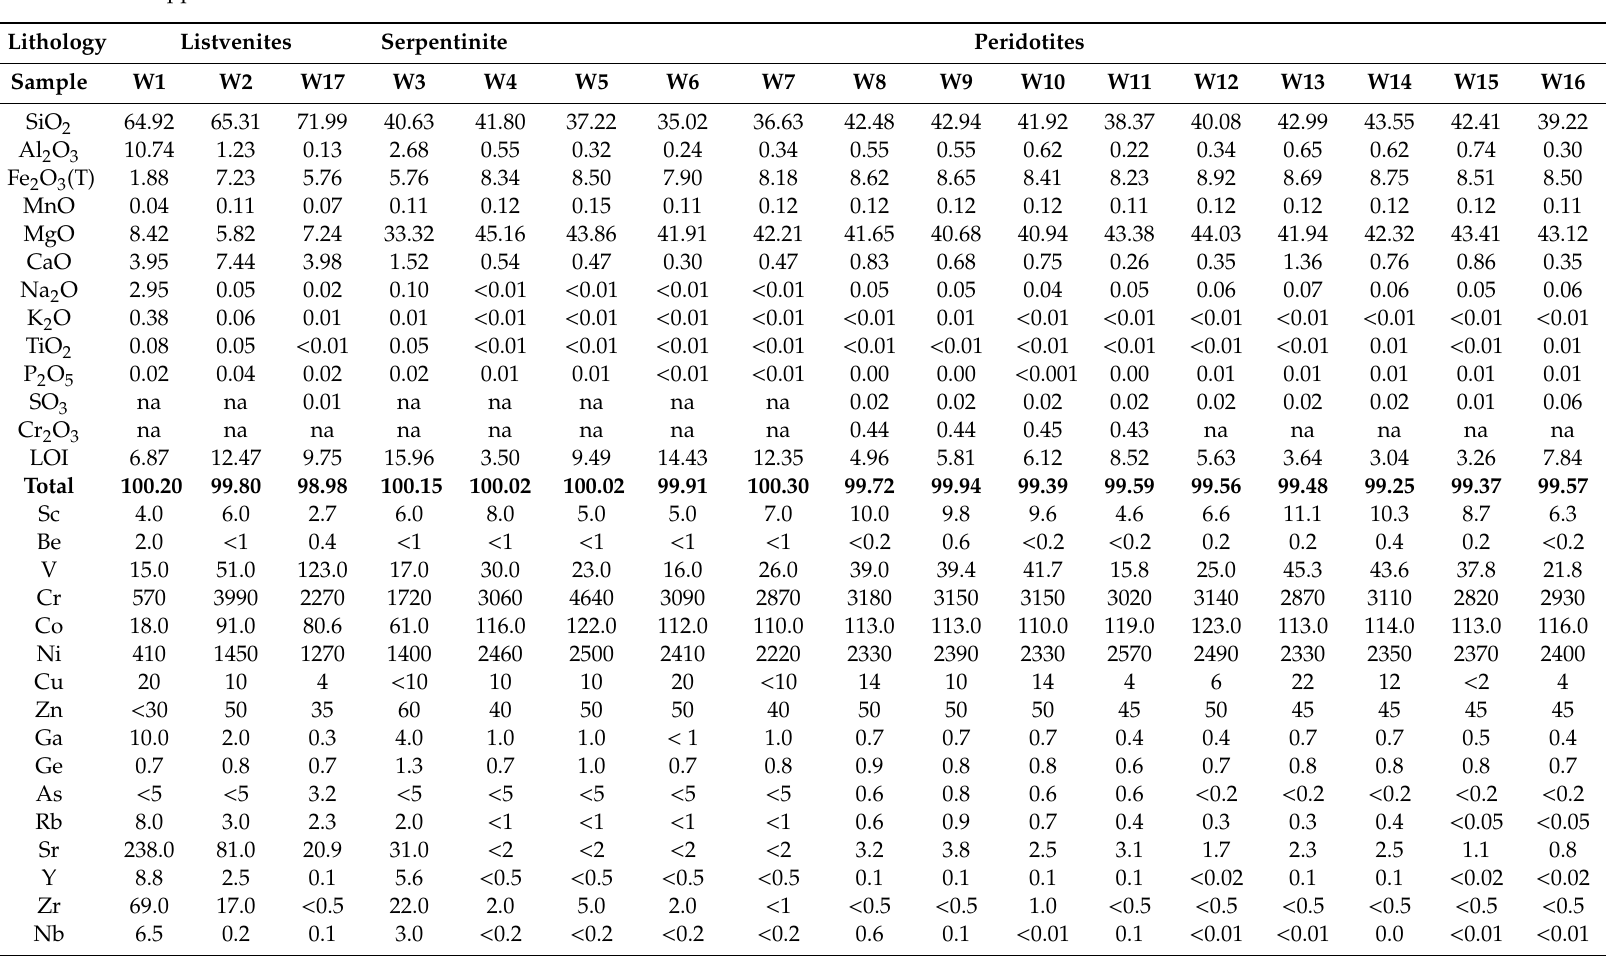
Table 2. Whole rock compositions of the studied samples. Oxides and loss of ignition (LOI) concentration values are presented in wt.% and trace elements concentrations in